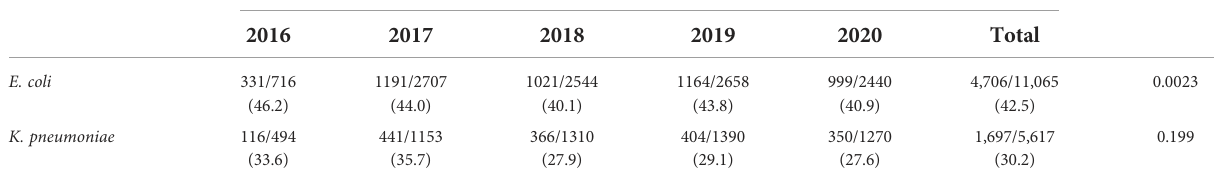
TABLE 1 The prevalence of ESBL-producing E. coli and K. pneumoniae isolates per year (between 2016 and 2020).